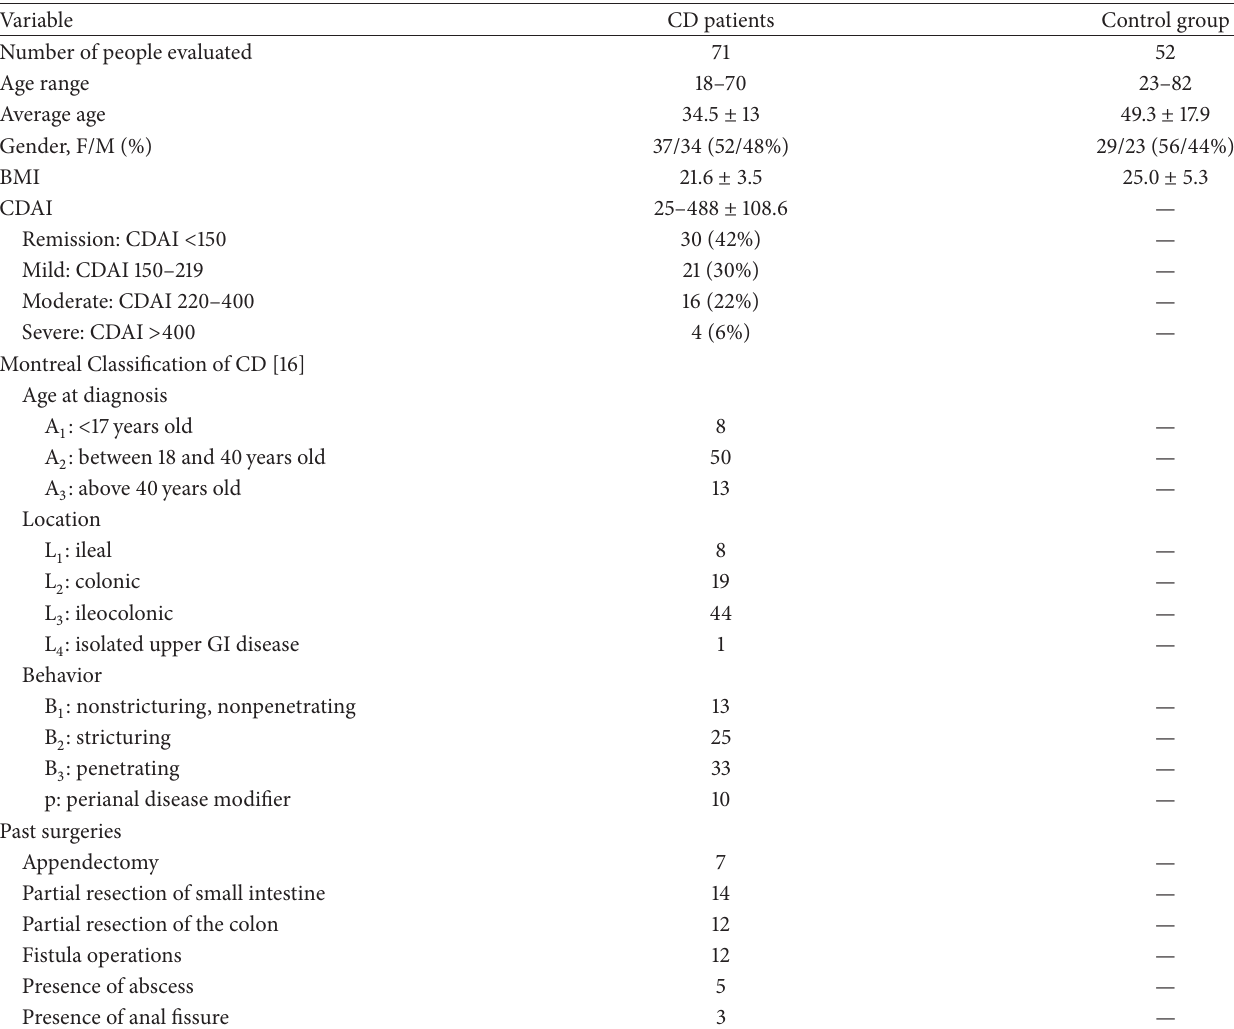
Table 3: Characteristics of the studied CD patient group and control group, for which assessments were performed in clinical, endoscopic, and histological indexes.